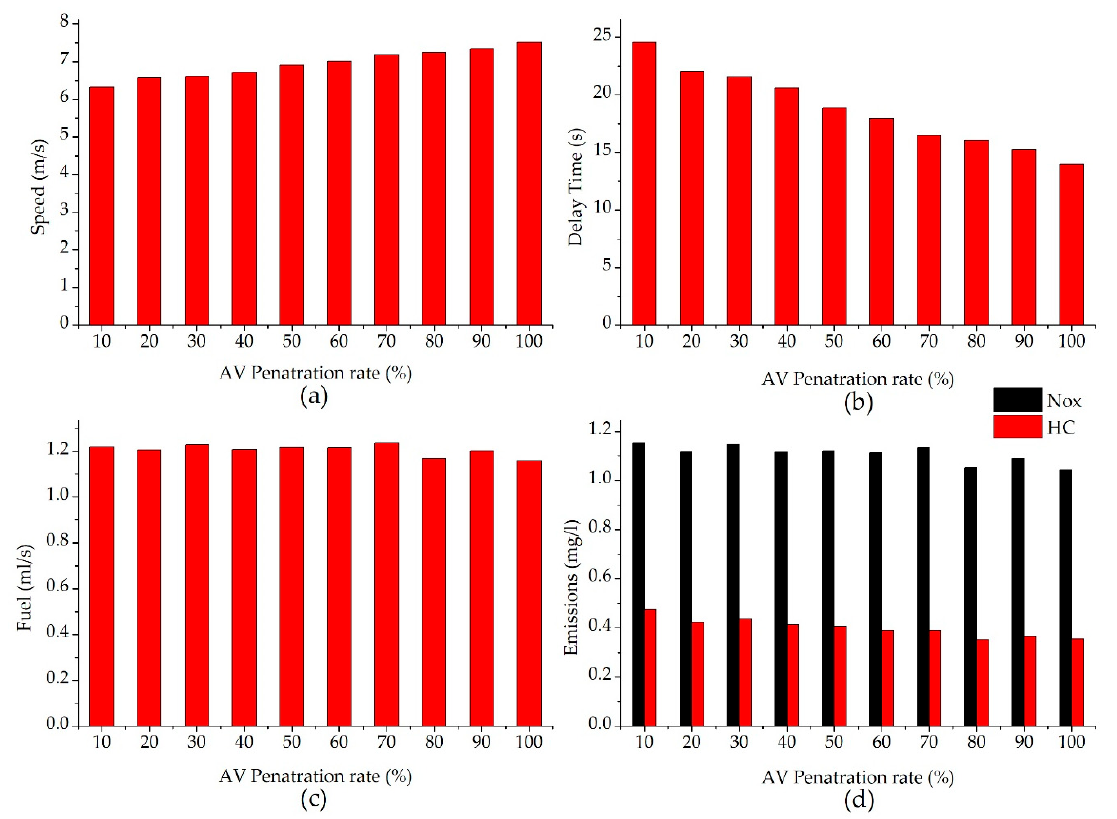
Figure 9. The results of the measures of effectiveness (MOE) evaluation based on the AV penetration rate: ( a ) average speed vs. AV penetration rate; ( b ) delay time vs. AV penetration rate; ( c ) fuel consumption vs. AV penetration rate; and ( d ) emissions vs. AV penetration rate.